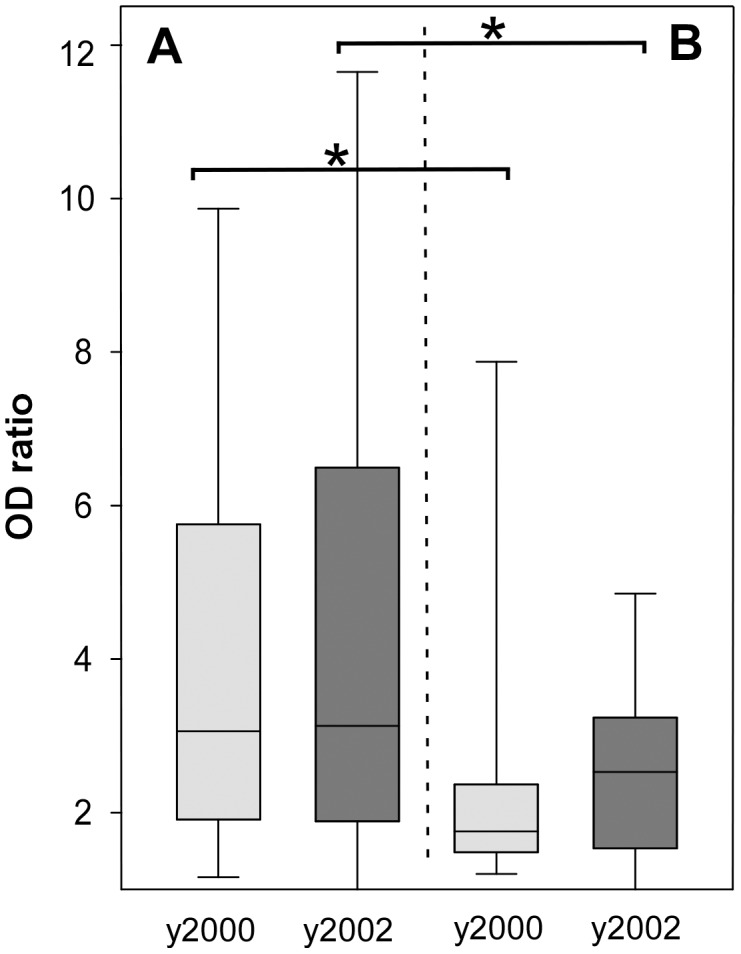
Longitudinal comparison of anti-PfMSP5 antibodies in Ndiop.Anti-PfMSP5 IgG responses for the 141 Ndiop villagers participating to two cross-sectional studies are shown. Ab responses were measured in both 2000 (light gray) and 2002 (dark grey). A box-whisker plot shows levels of Ab responses of individuals with the same profile ie positive or negative responses for both years (A). In part B are plotted Ab responses of 36 sera from individuals with discordant anti-PfMSP5 response in the two periods. Brackets indicate significant different levels between the two subgroups of villagers present in the two studies. The individuals with discordant responses from both surveys showed significantly lower Ab levels than those showing concordant responses (P<0.001).